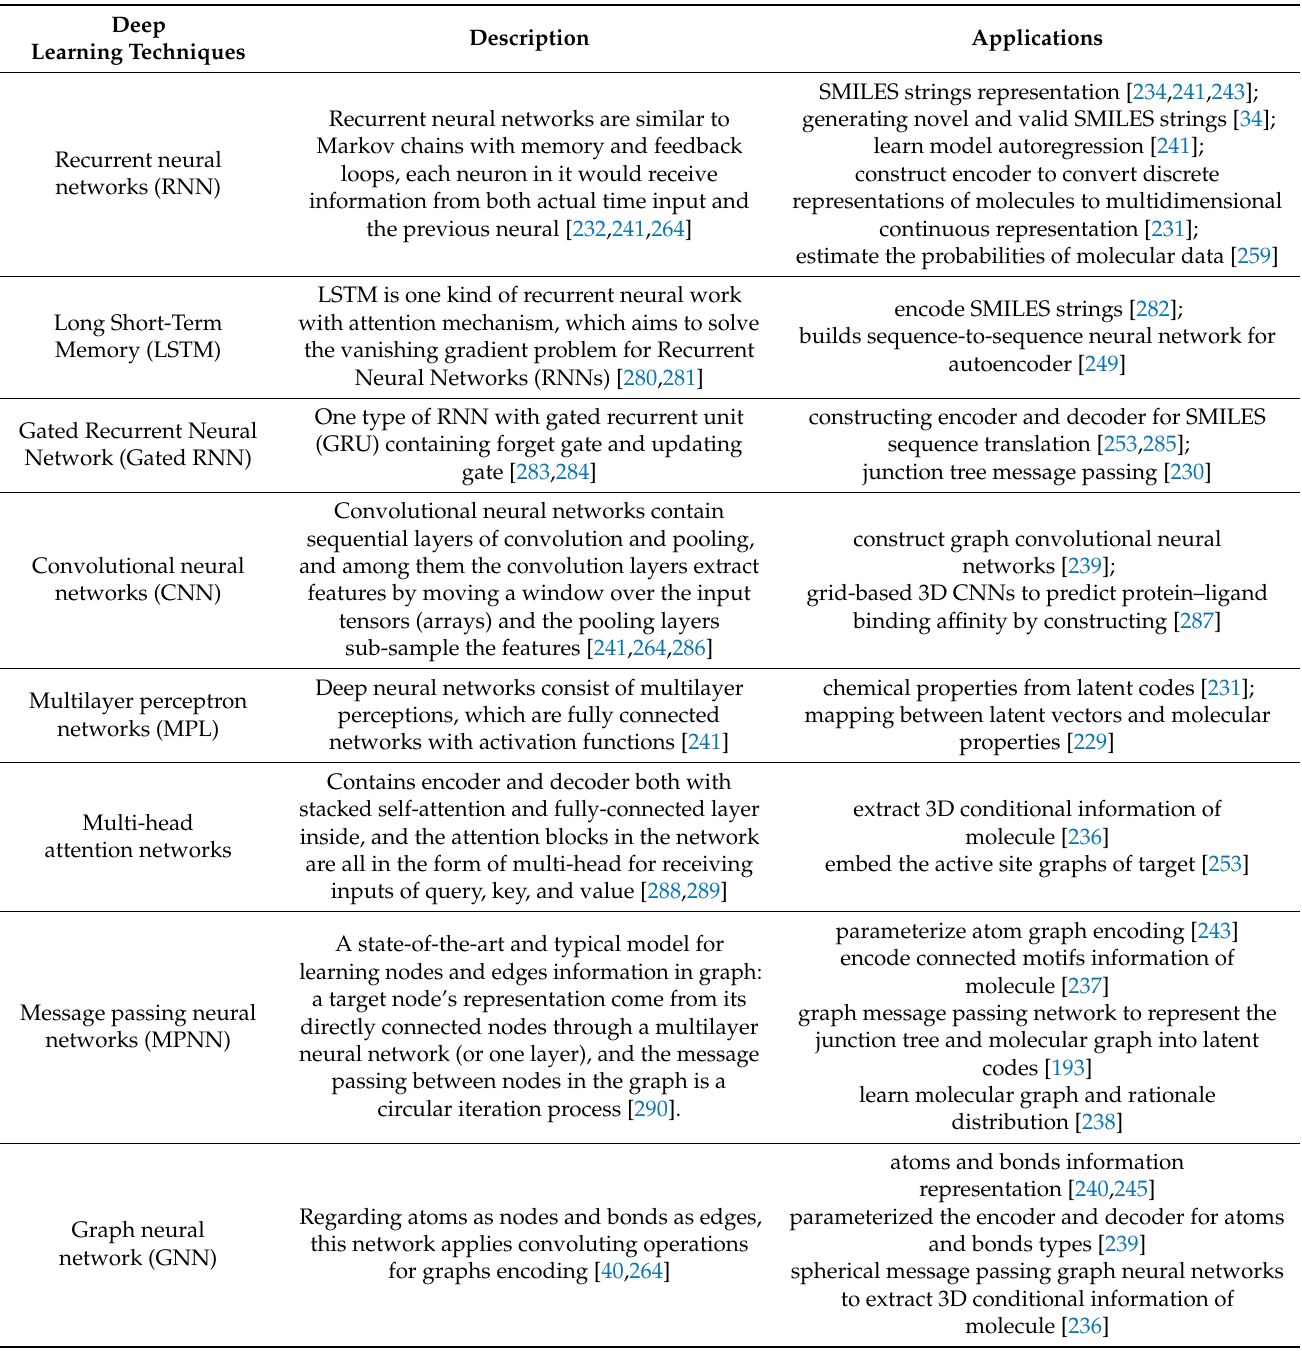
Table 2. Deep learning techniques in molecules